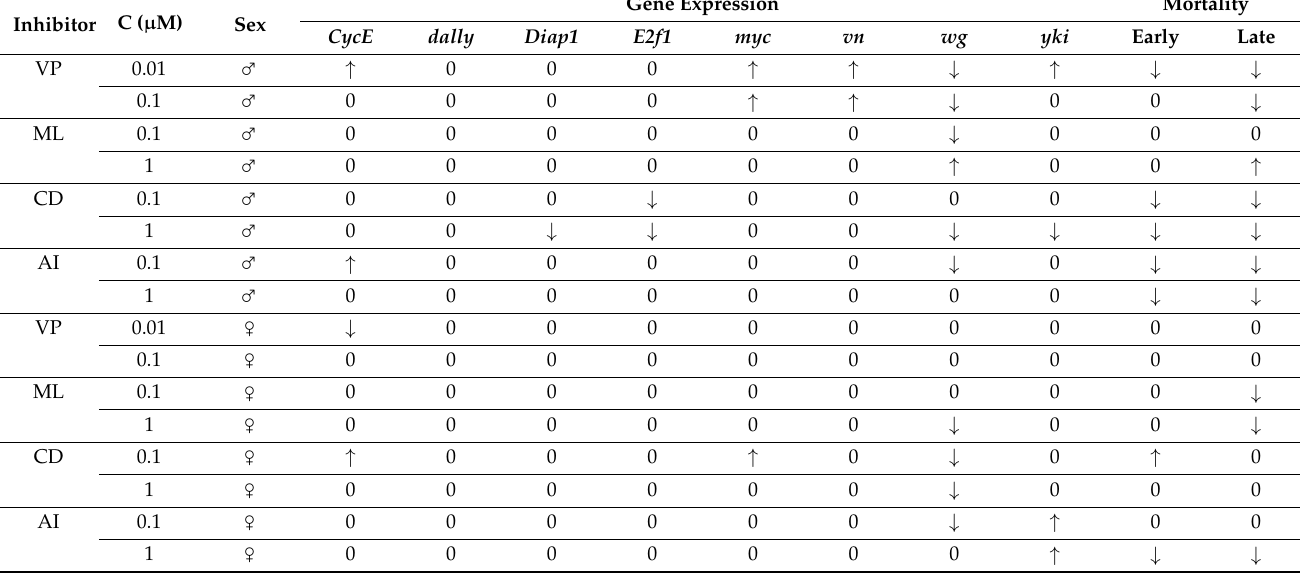
Table 1. Overall effects of Drosophila treatment with Yap/Taz inhibitors for 10